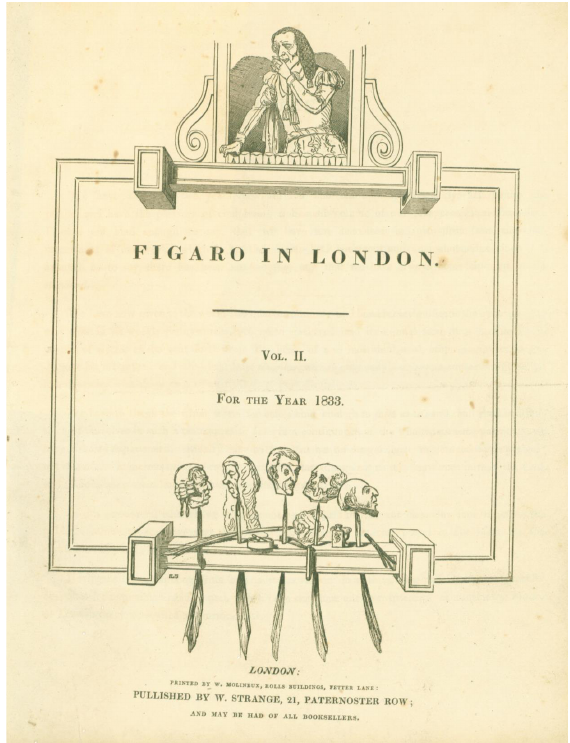
The title page of the second volume of Figaro in London (London: William Strange,